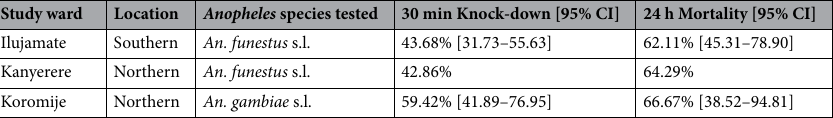
Table 5. Average 30-min knock-down and 24-h mortality to the diagnostic dose of alpha-cypermethrin (CDC bottle bioassays: 12.5 µg/ml), among wild Anopheles species, collected from three study clusters in Misungwi,